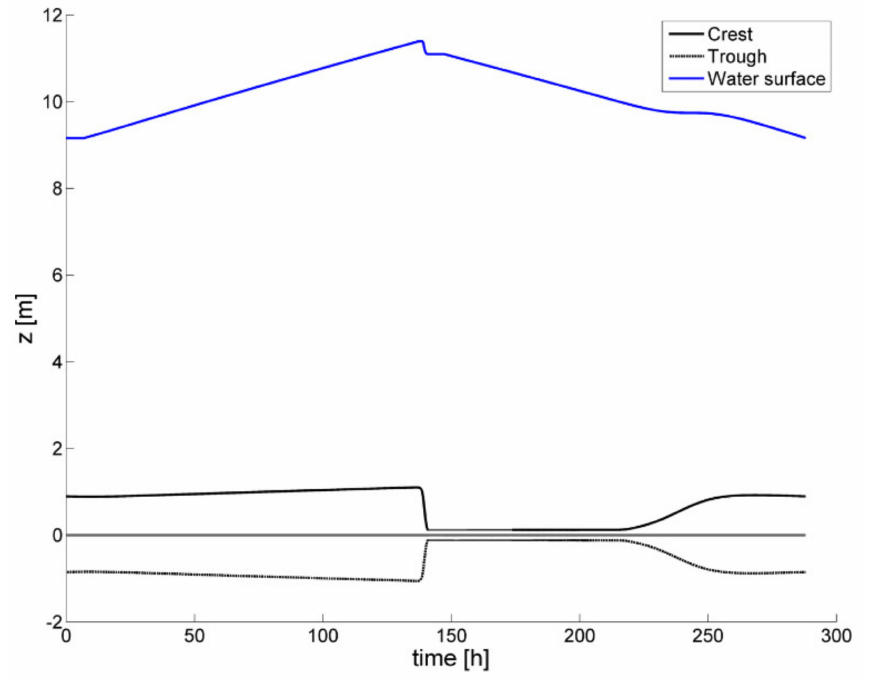
Figure 17. Dune field over time, using the more extreme river scenario. The right part zooms in on the dune field in the period where the transition occurs.